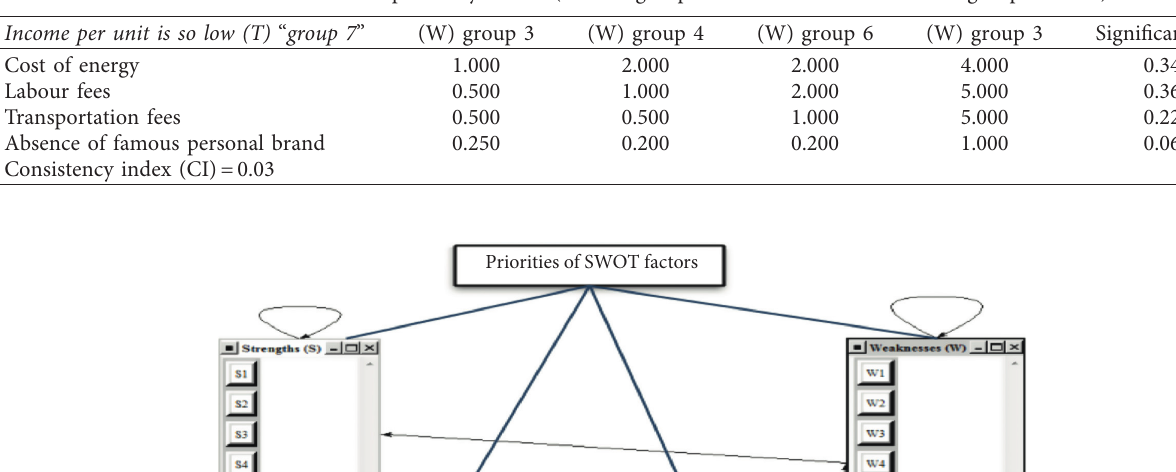
Table 11: An instance of dependency matrix (threats’ group element affected weaknesses’ group element).